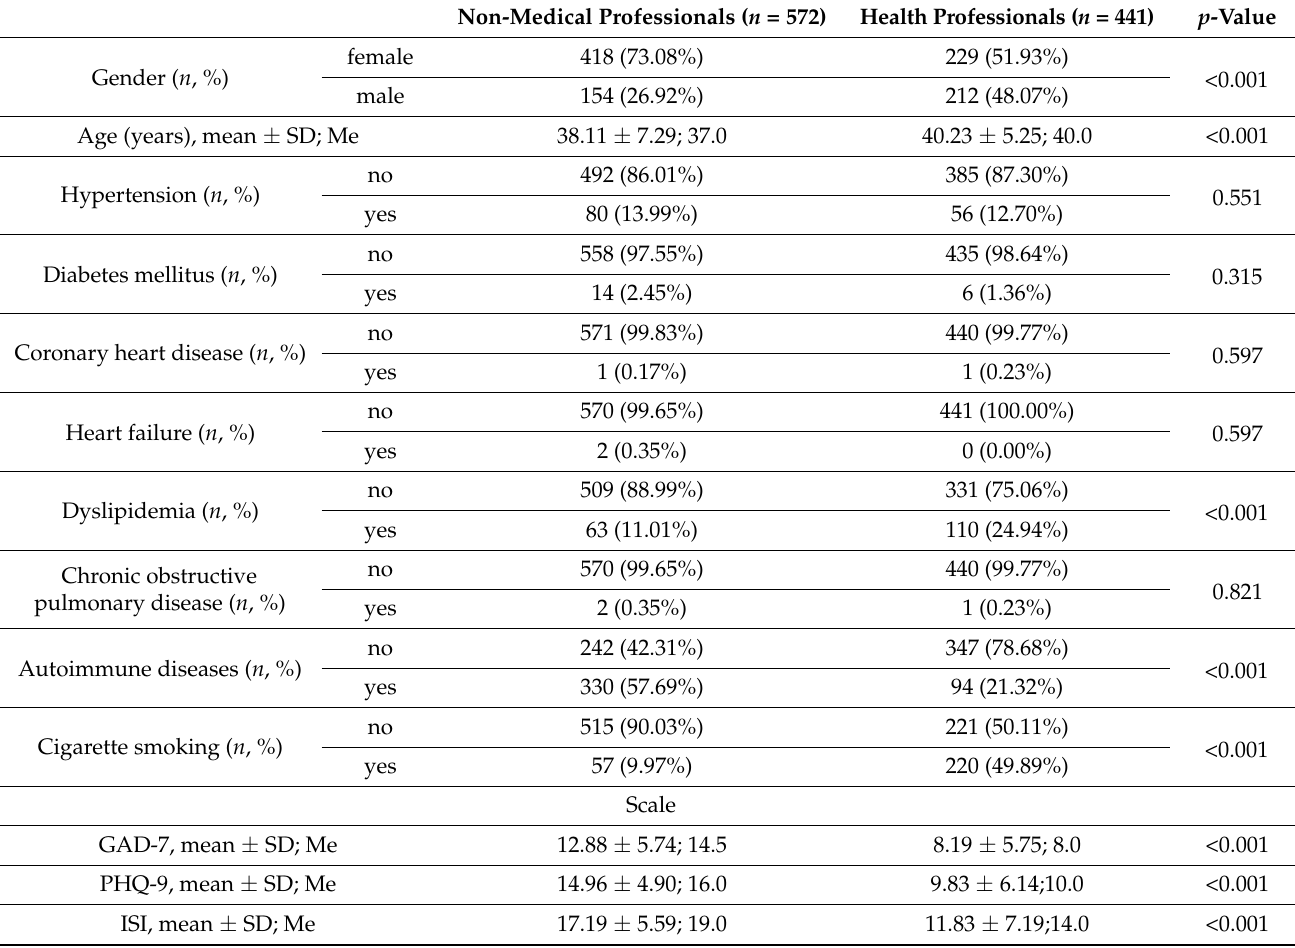
Table 1. Comparison of selected parameters between health professionals and non-medical